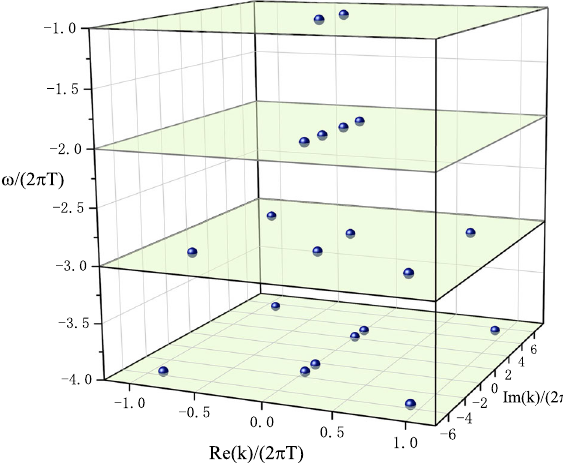
Fig. 1 The pole-skipping points in acoustic black holes embedded in Minkowski spacetime